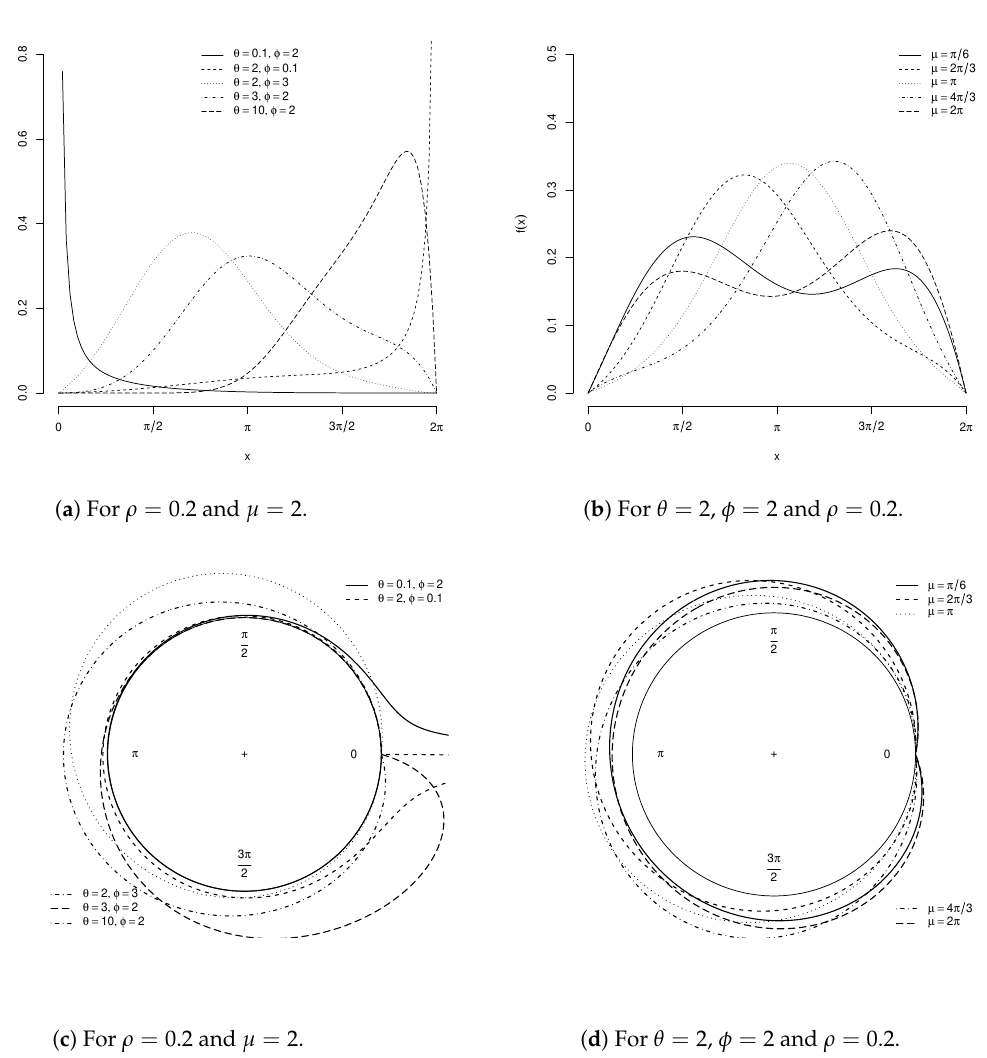
Figure 2. Cartesian and circular KwC densities for some parametric